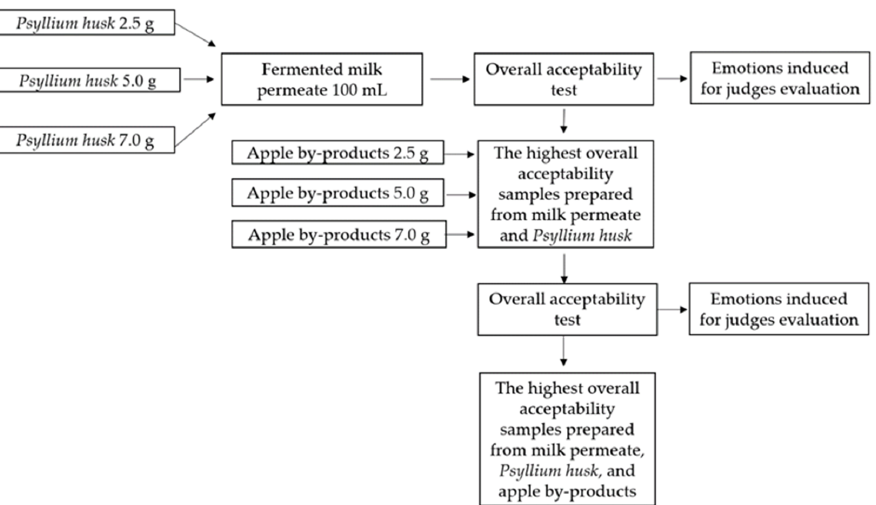
Figure 1. Scheme for selecting psyllium husk (Ph) and apple by-products for preparation of nutraceutical chewing candy (CCN).